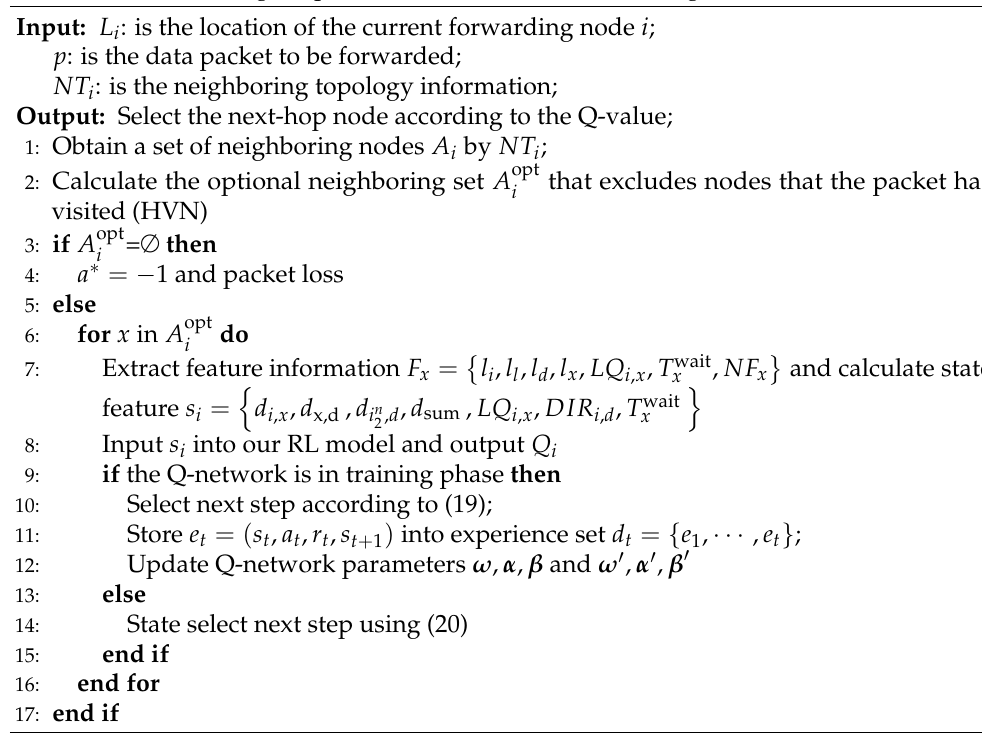
Algorithm 1 Delay-aware and link-quality-aware geographical routing forwarding protocol for UANET via dueling deep Q-network at current forwarding node